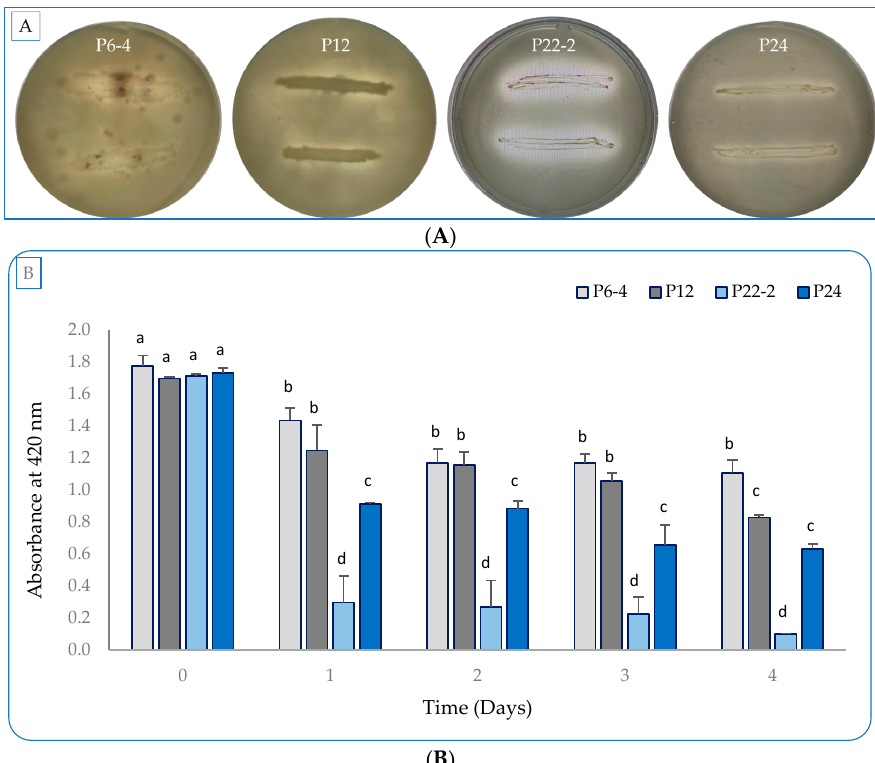
Figure 1. Inorganic-phosphate solubilization by the four isolated bacterial strains (P6-4, P12, P22-2, and P24) grown in NBRIP medium for 4 days. ( A ) The four strains growing on NBRIP agar medium with clear zones. ( B ) The solubilization efficiency of selected strains in NBRIP liquid medium. Each value represents the mean of three replicates. Bars with different letters are significantly different ( p > 0.05). Error bars represent the standard deviation of the